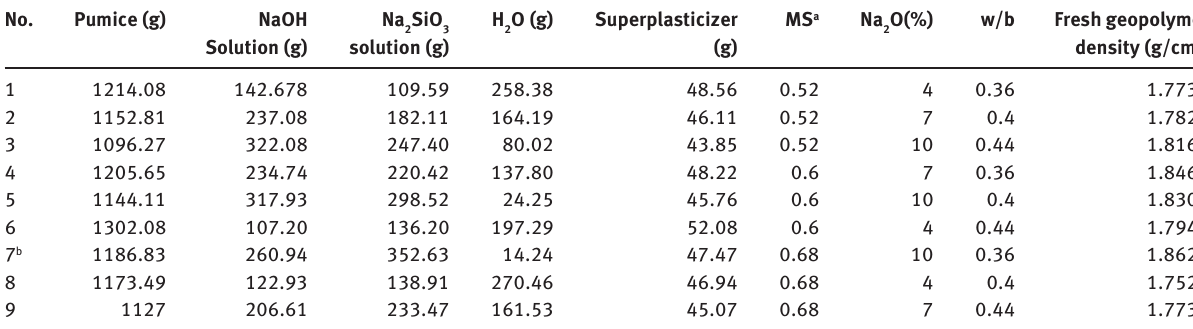
Table 6 Mix proportions for Hasankale-reinforced pumice-based